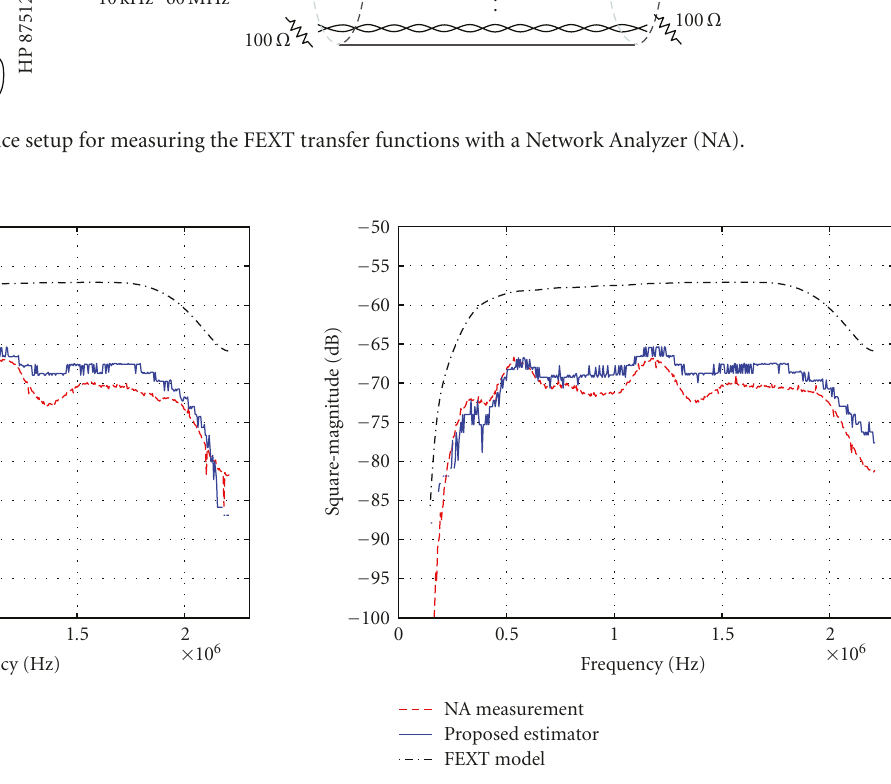
Figure 12: Square-magnitude of the lower FEXT channel in access network scenario I obtained with the NA, the FEXT model, and the proposed